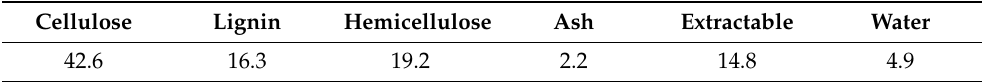
Table 1. Chemical composition of date stone flour